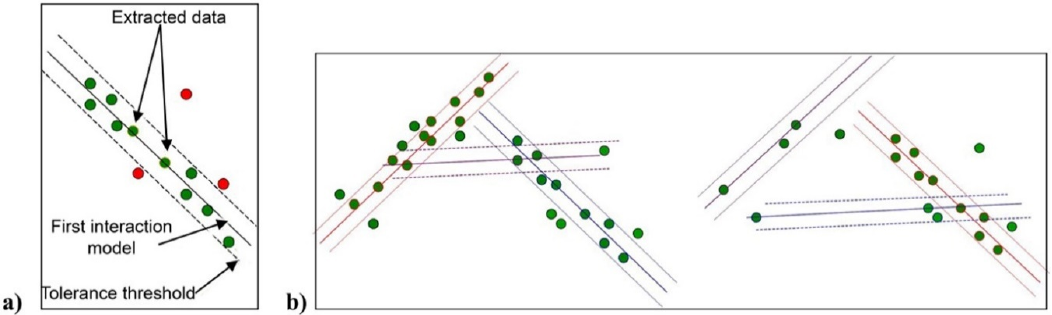
Figure 4. Individuation of the interpolating line in the case of a single dataset ( a ), and of multiple datasets ( b ).